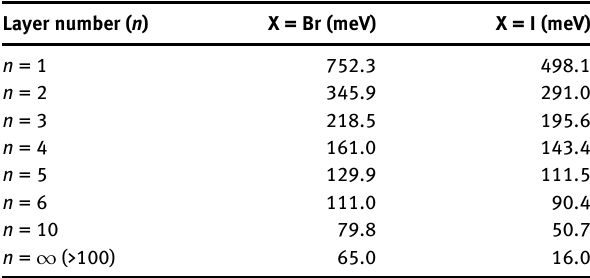
Table  : Exciton binding energies of halogen ions with different layers [  , 